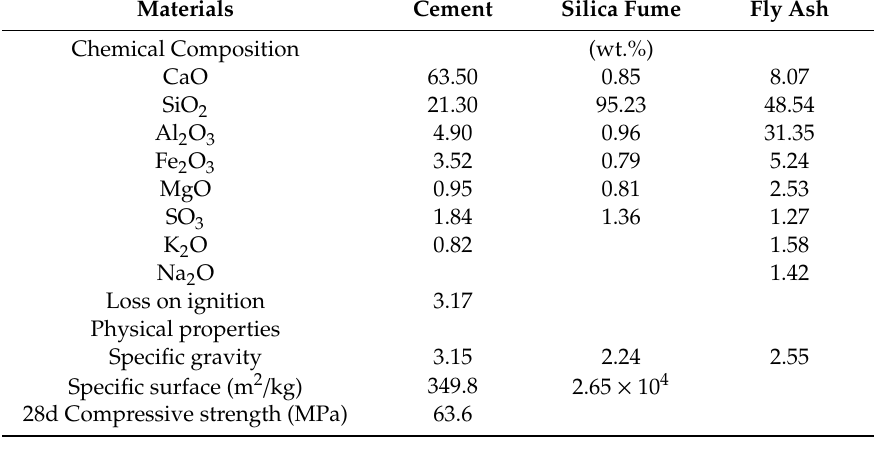
Table 1. Chemical composition and physical properties of cement, silica fume, and fly ash.